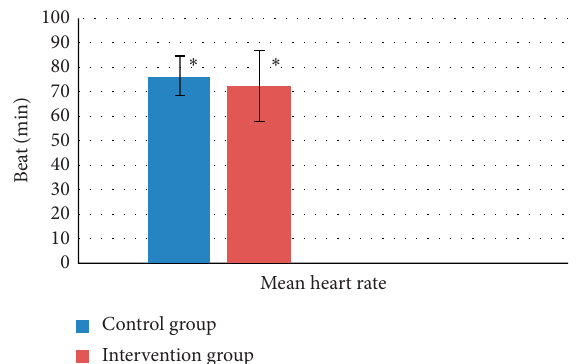
Figure 2: Te mean of heart rate variations in both groups during the study period. ∗ P � 0.454 and not signifcant.